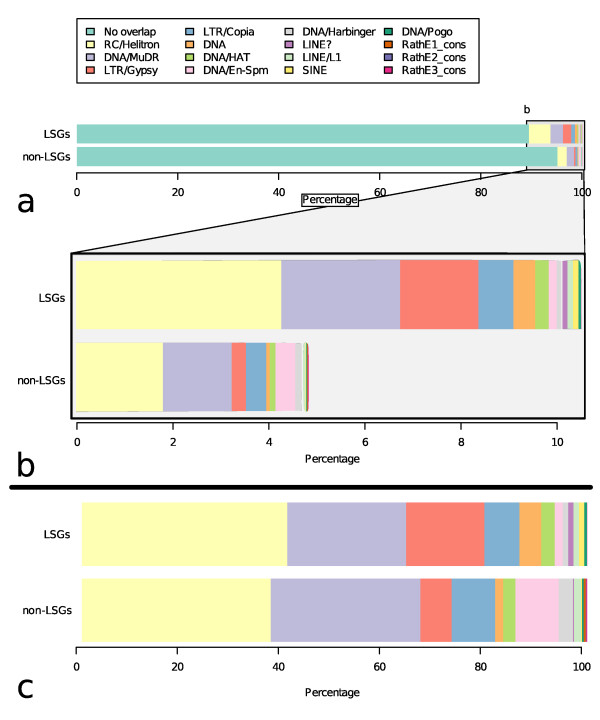
Summary of transposon exaptation frequency in LSG and non-LSG CDS. a) The frequency of exaptation of each TE super-family for all genes; split into LSG and non-LSGs. b) Close up view of a) where there is evidence of TE exaptation in LSGs and non-LSGs. c) The frequency of each TE super-family exapted in those genes containing exapted TE DNA, split into LSG and non-LSGs. Note, some genes have exapted DNA from several super-families, each case is reported therefore the total percentage is marginally over 100% to reflect this.